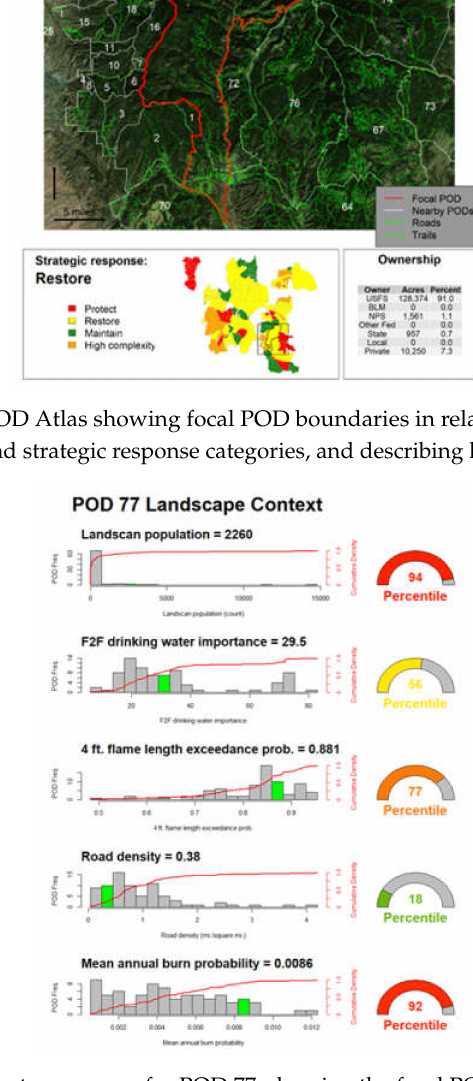
Figure 6. Graphical attribute summary for POD 77, showing the focal POD in relation to histograms, cumulative distributions, and percentiles across all PODs, for Landscan-based population, drinking water importance (F2F = Forests to Faucets), simulated flame lengths, road density, and simulated burn